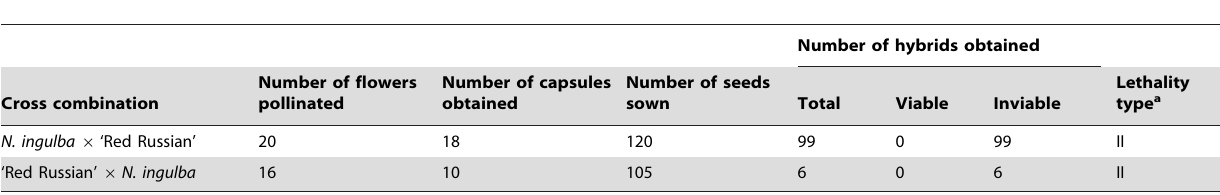
Table 3. Viability of reciprocal hybrids between N. tabacum and N. ingulba at 28 u C.